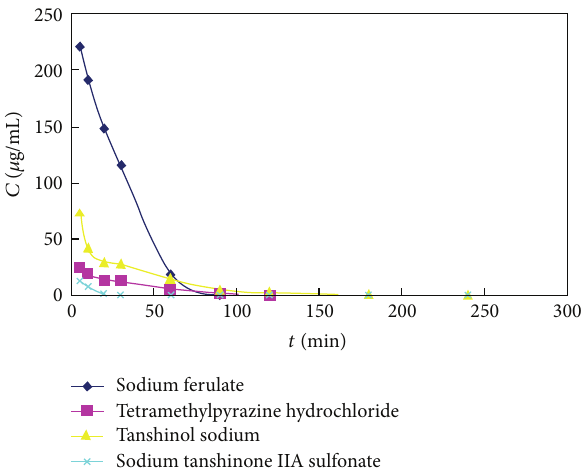
Figure 5: The profile of concentration versus time kinetic curves after